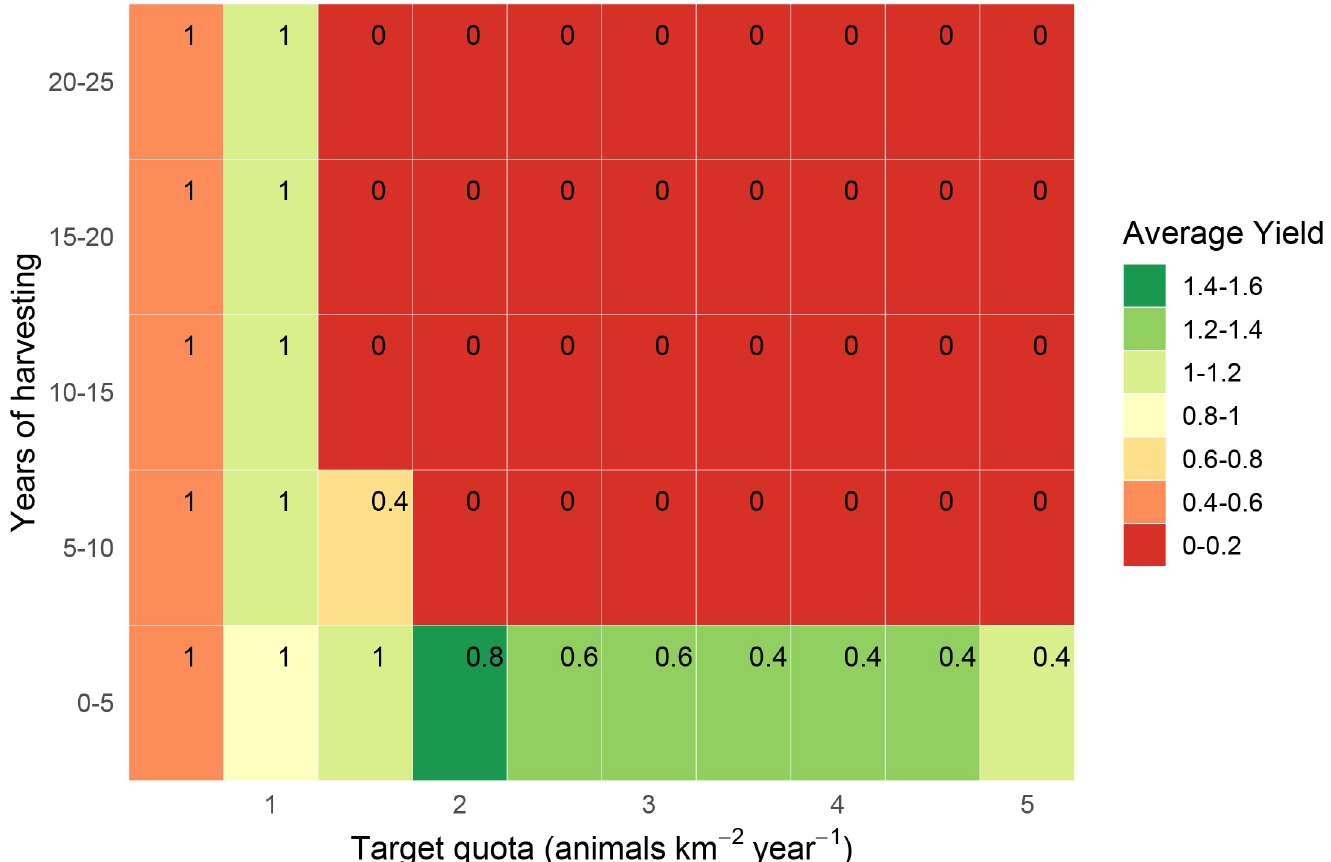
Fig 3. Estimated yields (animals km -2 year -1 ) from quota-based harvesting of Peters’ duiker C . callipygus . Yields are estimated over 25 years in 5-year increments, without parameter uncertainty, with corresponding survival probabilities (in top-right corner of each rectangle).